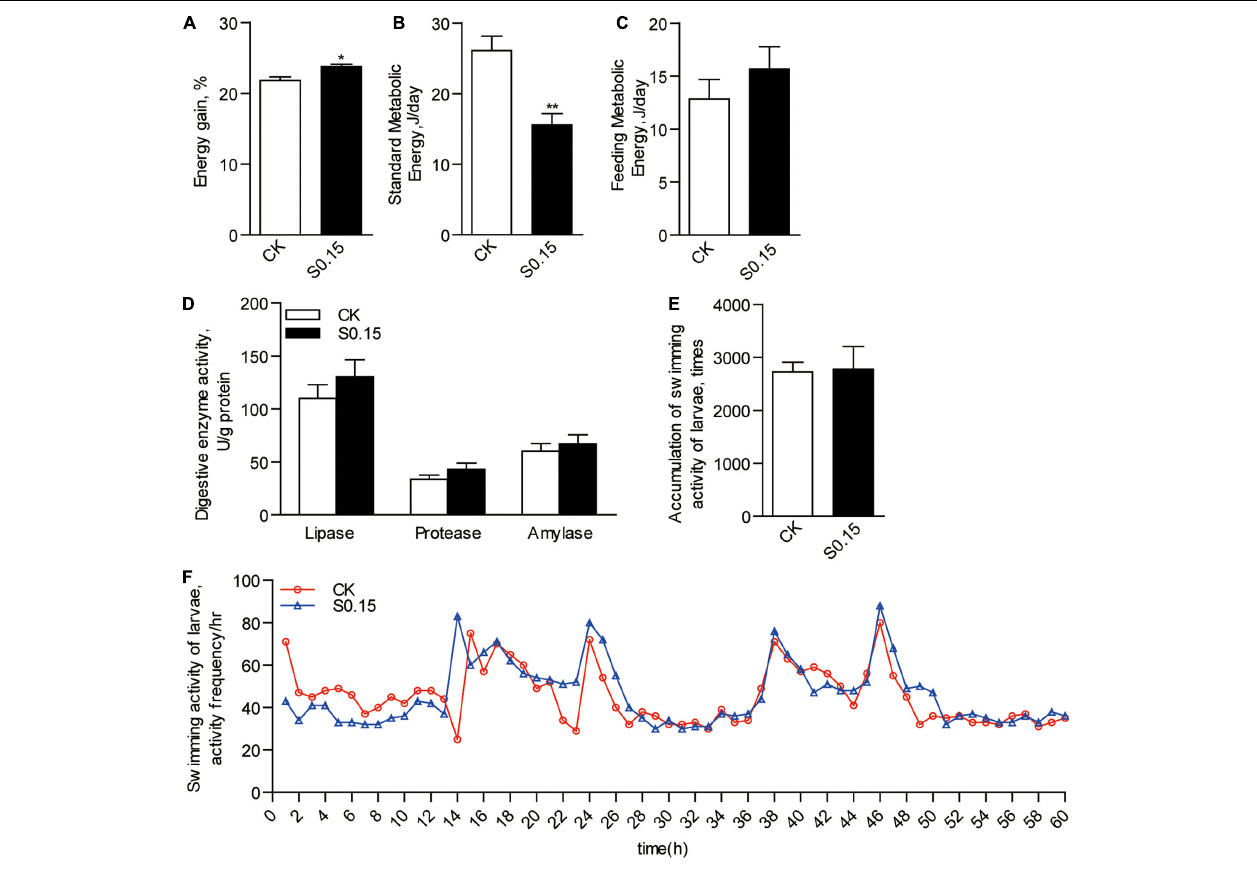
FIGURE 3 | Energy budget in zebrafish fed the CK or S0.15 diet for 4 weeks. (A) Whole body energy gain. (B) Standard metabolic energy. (C) Feeding metabolic energy. (D) Digestive enzyme activities. (E) Accumulation of swimming activities and (F) representative swimming activities of zebrafish larvae fed the CK or S0.15 diet for 1 week. Values are means ± SEMs ( n = 4–6 biological replicates). * p < 0.05, ** p < 0.01. CK, control-check diet; S0.15, 0.15% succinate-supplemented